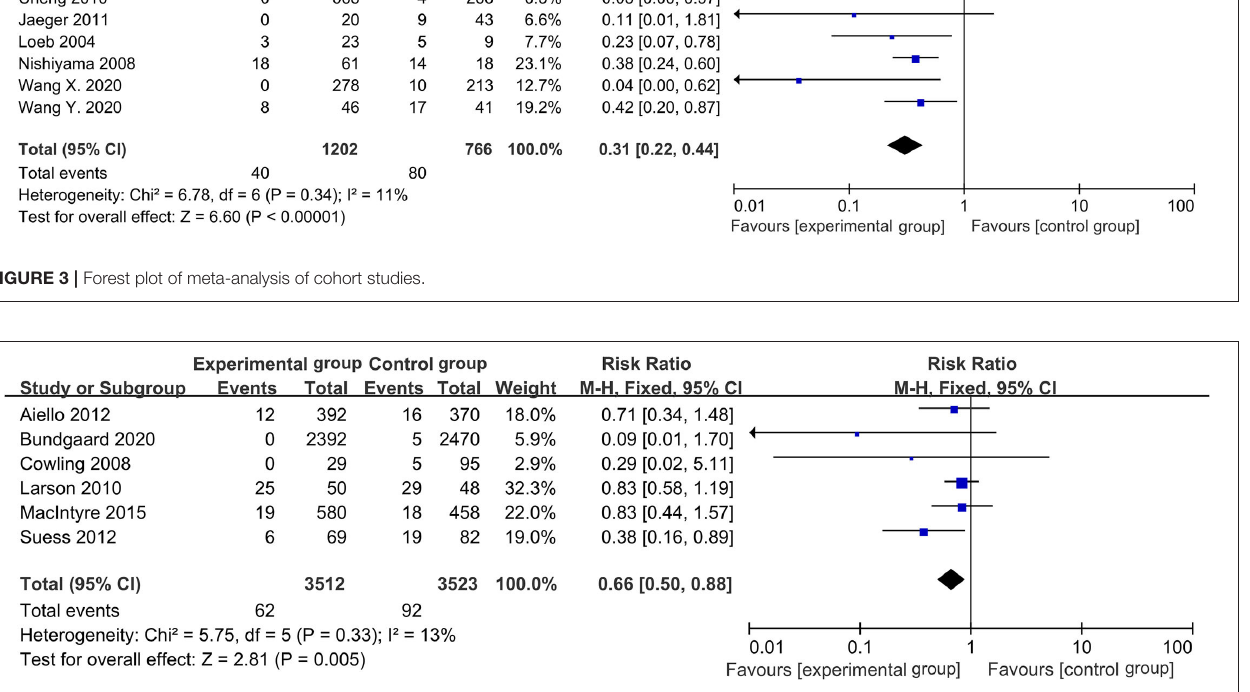
FIGURE 4 | Forest plot of meta-analysis of